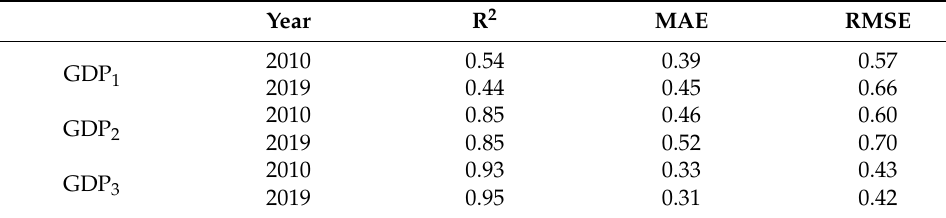
Table 1. Cross-Validation of the RF Model for Different Sectors. Year R 2 MAE